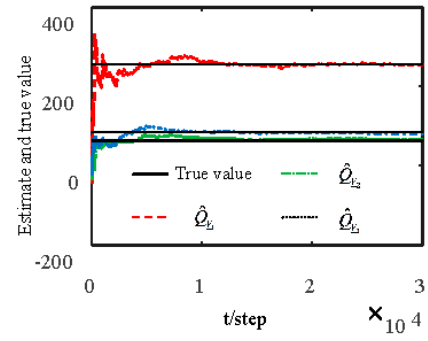
Figure 10. Identification of noise variances Q V